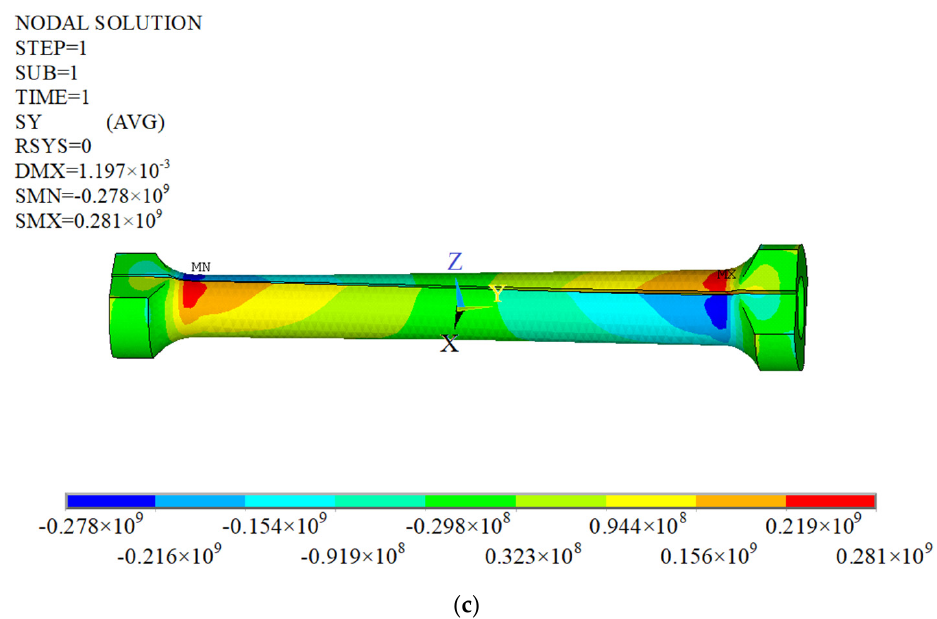
Figure 11. Stress and strain diagram of the thin-walled bar with an open cross-section under the action of 30 Nm torque. ( a ) Comprehensive strain of the bar. ( b ) Normal stress of the bar. ( c ) Shear stress of the bar.